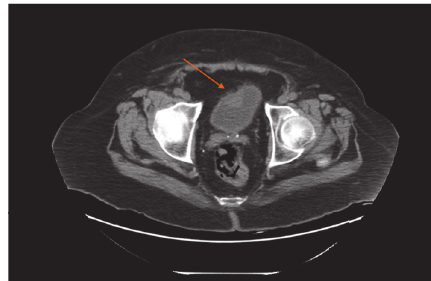
Figure 1: 3.2 × 1.7 × 2.7 cm mass in the anterior wall of the urinary bladder.